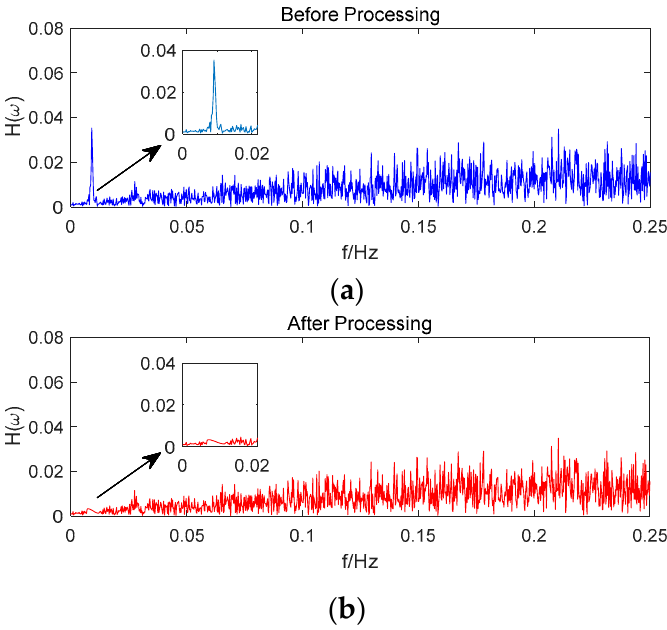
Figure 23. ( a ) Frequency spectrum before smoothing with the spectrum peaks extracting method and CMCD correction model, G06, ( b ) Frequency spectrum after smoothing with the spectrum peaks extracting method and CMCD correction model, G06.